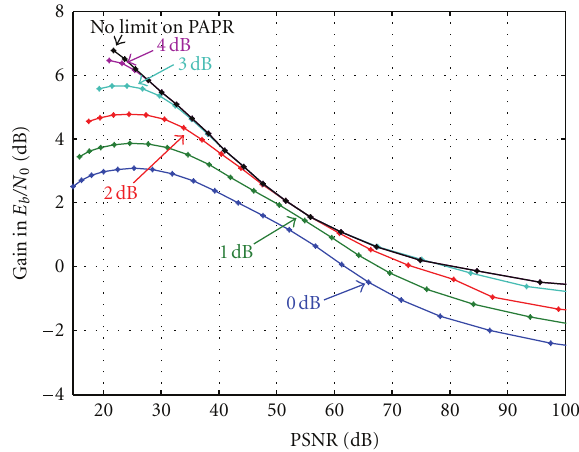
Figure 5: Improvement in the PSNR of power optimized variable M -QAM when compared with conventional 16-QAM.